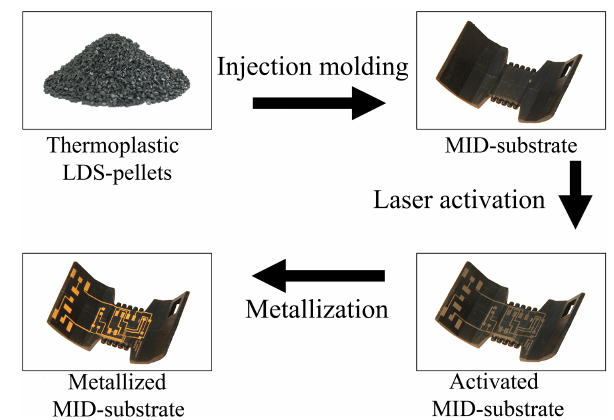
Figure 1. Manufacturing process of a 3D-MID substrate with flu- idic channels and conducting paths fabricated by laser direct struc- turing (LDS) (Schmidt et al.,